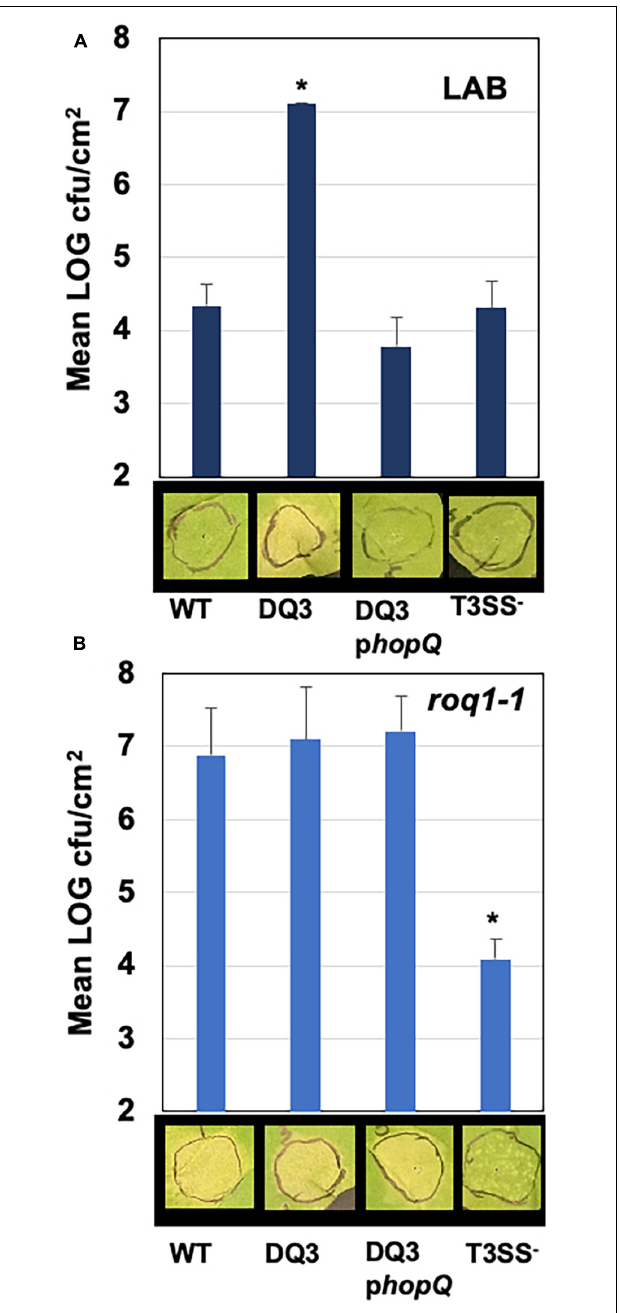
FIGURE 4 | PmaES4326 gains disease compatibility with N. benthamiana in the absence of hopQ / Roq1 -mediated ETI. The Pma ES4326 WT strain, Pma DQ3 ( (cid:49) ICE-DQ), DQ3 complemented with pCPP5372hopQ (DQ3pQ), and the non-pathogenic T3SS- strain hrcN :Tn 5 were infiltrated into leaves of the N. benthamiana Lab accession (A) or the roq1-1 CRISPR mutant derivative line (B) at 3 × 10 4 CFU/mL. Eight days post inoculation leaves were photographed to document symptoms and bacterial load from four 4 mm diameter leaf discs from each infiltrated area by dilution plating was determined as CFUs/cm 2 leaf tissue. Values are the means and standard deviations of LOG transformed CFUs/cm 2 from three inoculated plants. * p < 0.05 compared to Pma ES4326 WT strain as determined by unpaired one-tailed t -test.